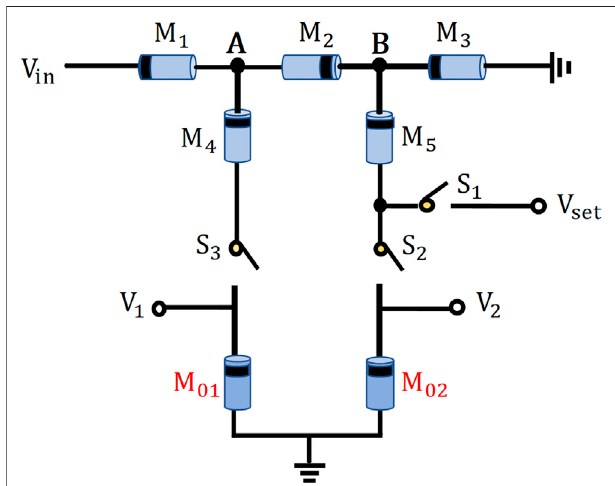
FIGURE4| Proposed π -structurememristor synapse.Itisdividedintoa basic repeatable unit and two additional memristors, where the repeatable unit forms two currents of different sizes by dividing the voltage and passing through memristors of different values, and the two additional memristors convert the current signal into voltage.